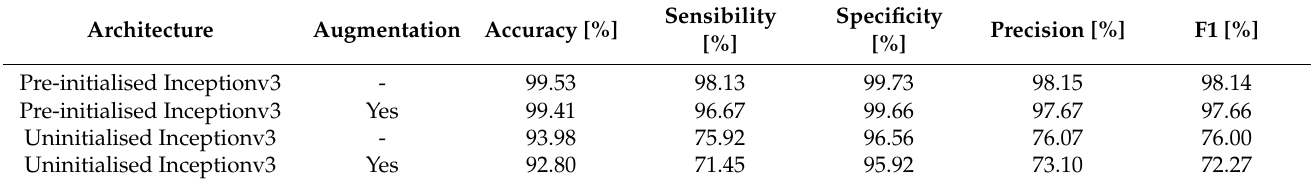
Table 8. InceptionV3 training results.